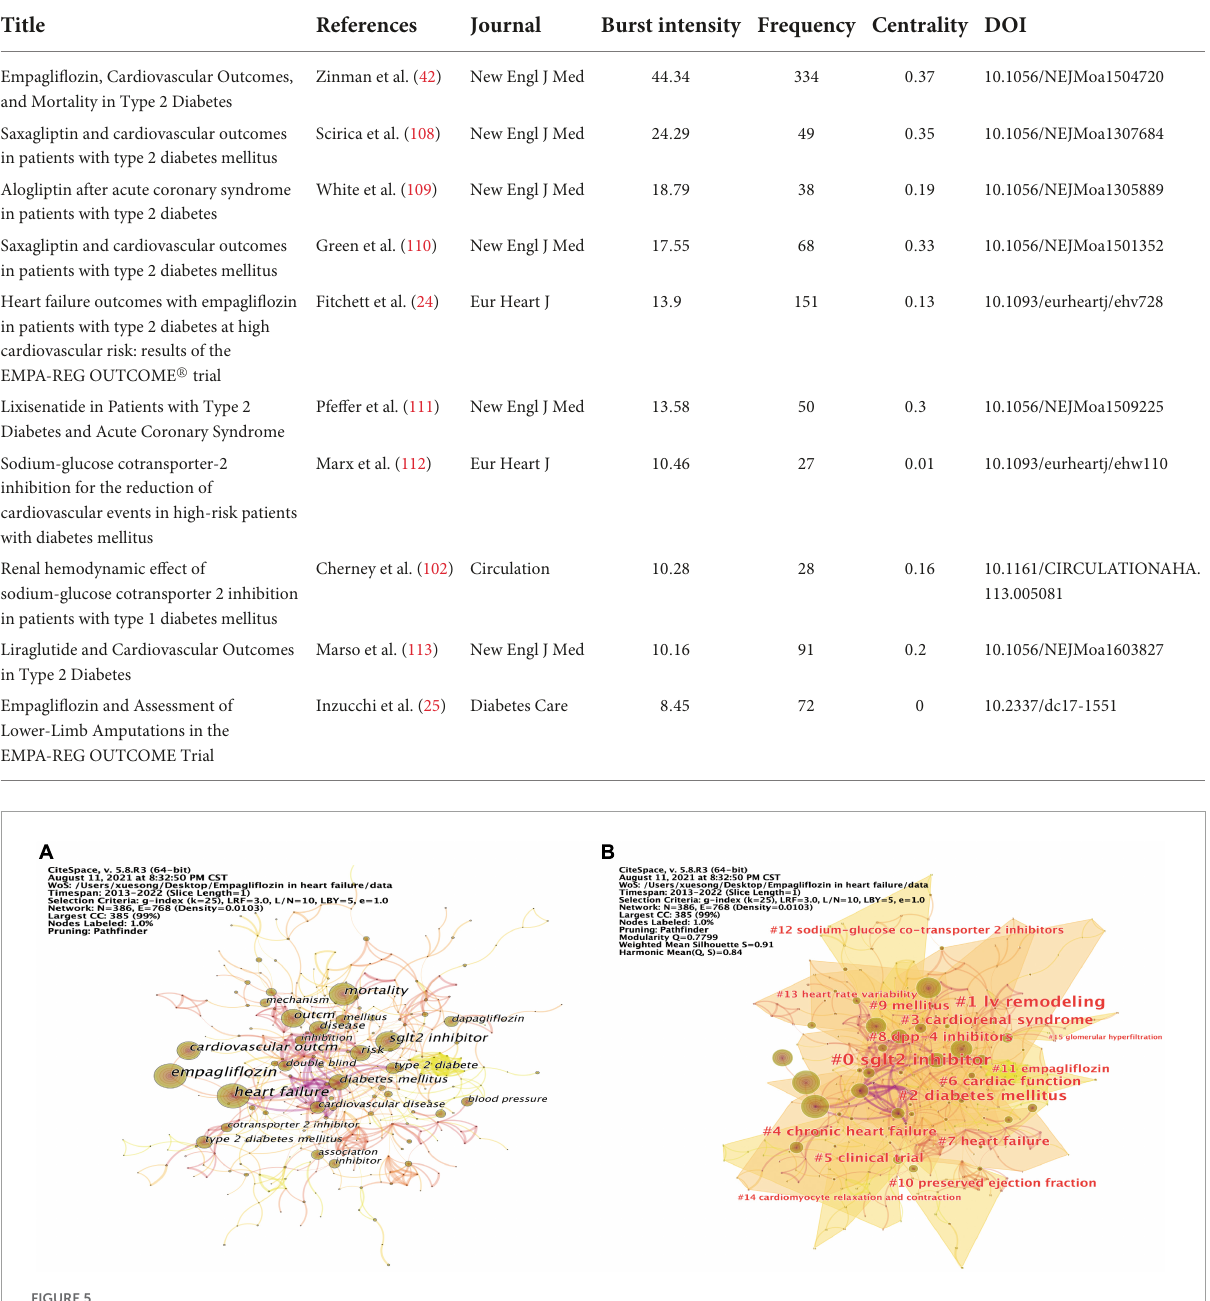
TABLE 9 The 10 co-cited references with burst intensity in the field of EMPA for HF.